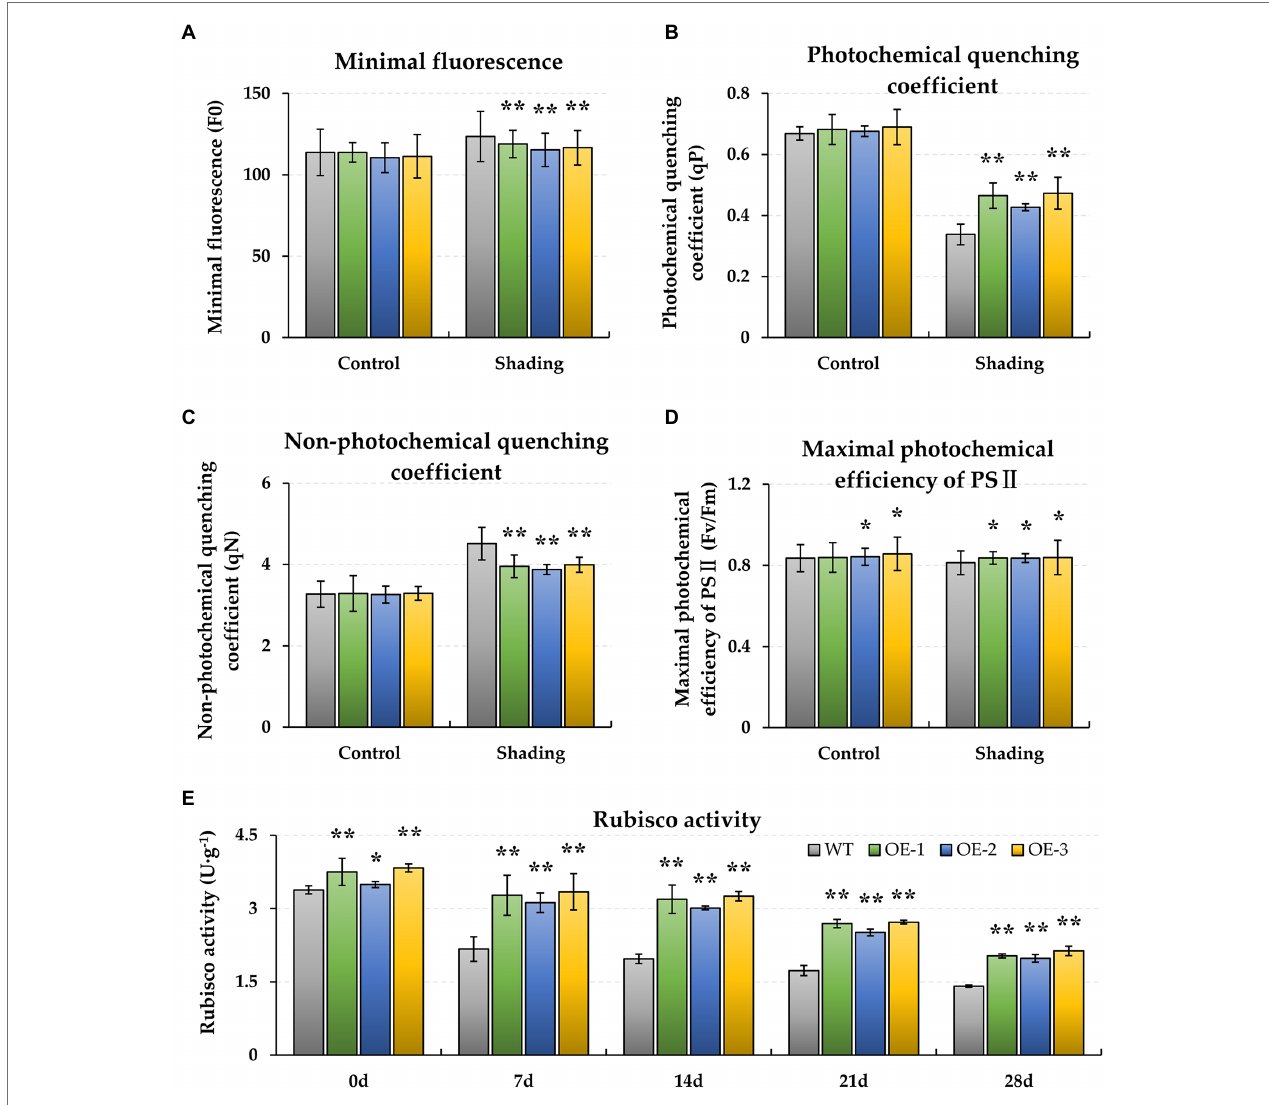
FIGURE 2 | Effect of shading stress on the chlorophyll fluorescence photosynthetic traits and Rubisco activity of WT and BnaMAPK1 -OE transgenic rapeseed. (A) Minimal fluorescence (F0). (B) Photochemical quenching coefficient (qP). (C) Non-photochemical quenching coefficient (qN). (D) Maximum photochemical efficiency of PS II (Fv/Fm). (E) Rubisco activity. The chlorophyll fluorescence parameters (F0, qP, qN, and Fv/Fm) were measured under control and shading conditions at 0 and 28 days each, and the Rubisco activity at 0, 7, 14, 21, and 28 days each. Vertical bars are means of three replicates ± SD (three plants of each line, three leaves of each plant, and 10 times of each leaf were measured); asterisk and double asterisk indicate p-value < 0.05 and p-value <